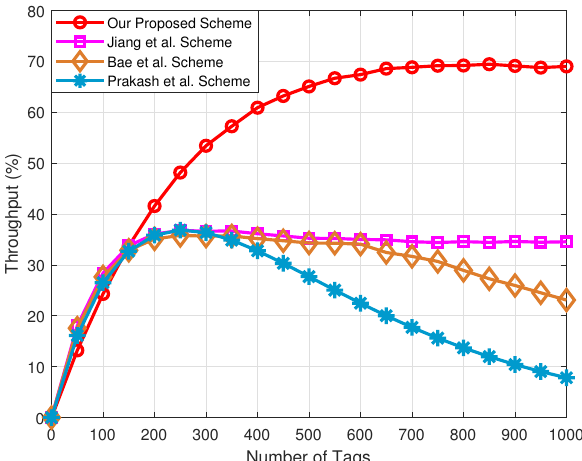
Figure 9. Comparison of the throughput rate with respect to the number of tags under the differ- ent